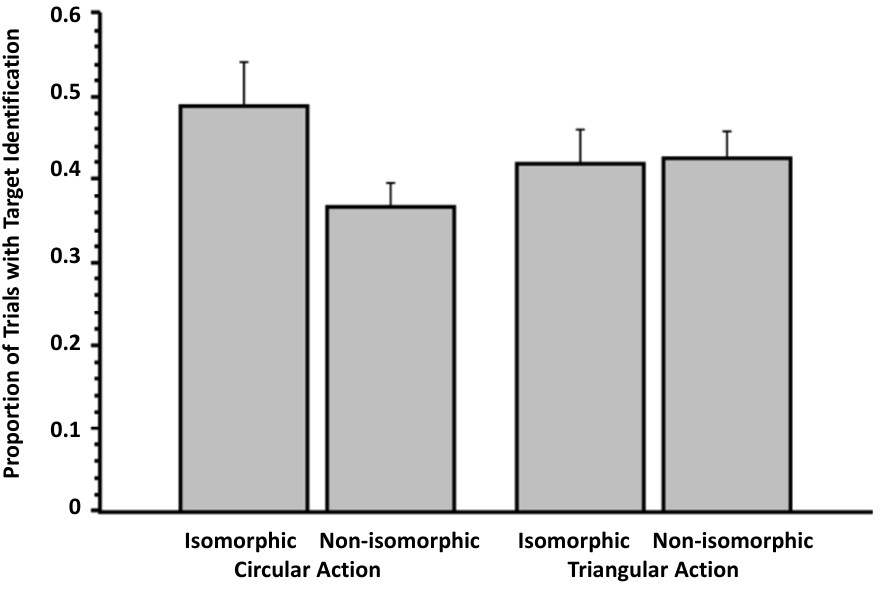
Figure 9. Proportion of trials in which participants correctly identified visual targets, as a function of action and isomorphism (Experiment 3). Data stem from the question, “Did you see any of the following targets? If YES, please indicate which one.” Error bars signify